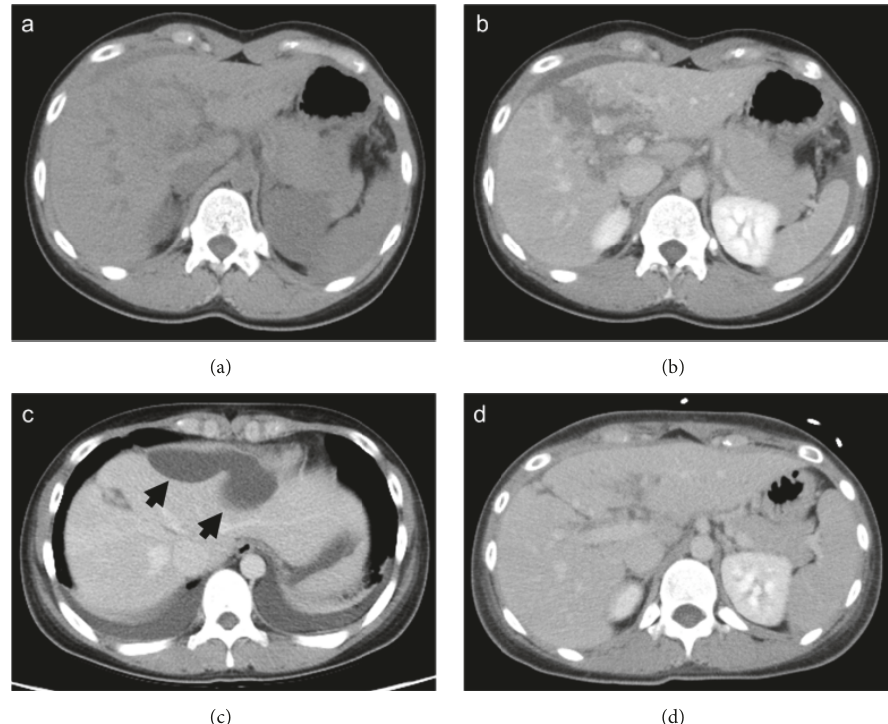
Figure 1: (a) Computed tomography (CT) performed on arrival at the hospital showing hepatic injury. (b) Enhanced CT performed on arrival at the hospital showing hepatic injury. (c) Enhanced CT performed on day 17 of hospitalization showing biloma (black arrows). (d) Enhanced CT performed on day 34 of hospitalization showing that the biloma had almost